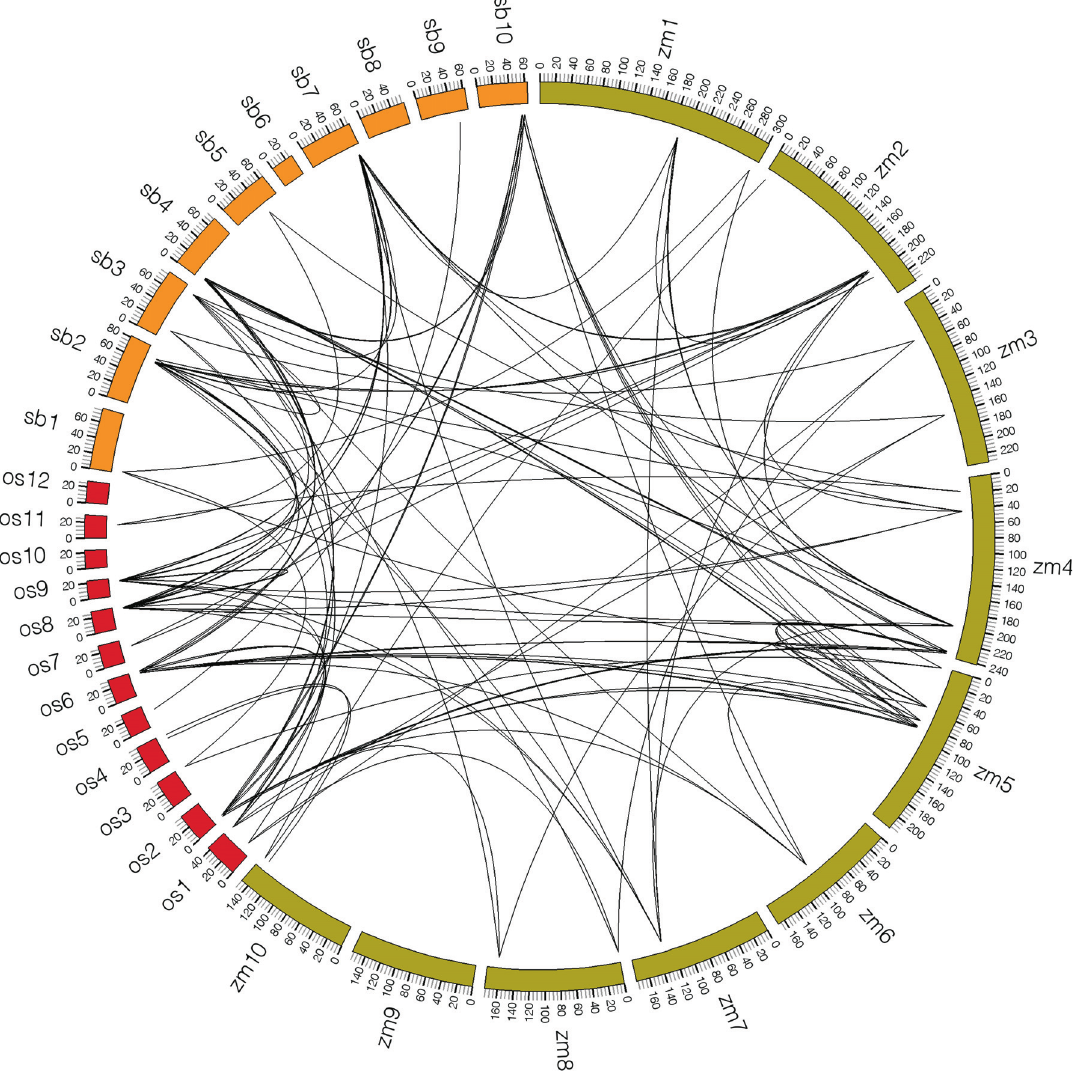
Figure 2 - Synteny analysis of 68 SPLs from maize, sorghum, and rice. Maize, sorghum and rice chromosomes were labeled zm, sb, and os by different color boxes, respectively. The numbers along each chromosome box indicate sequence length of each chromosome in megabases. Black lines represent the syntenic relationships of orthologous gene